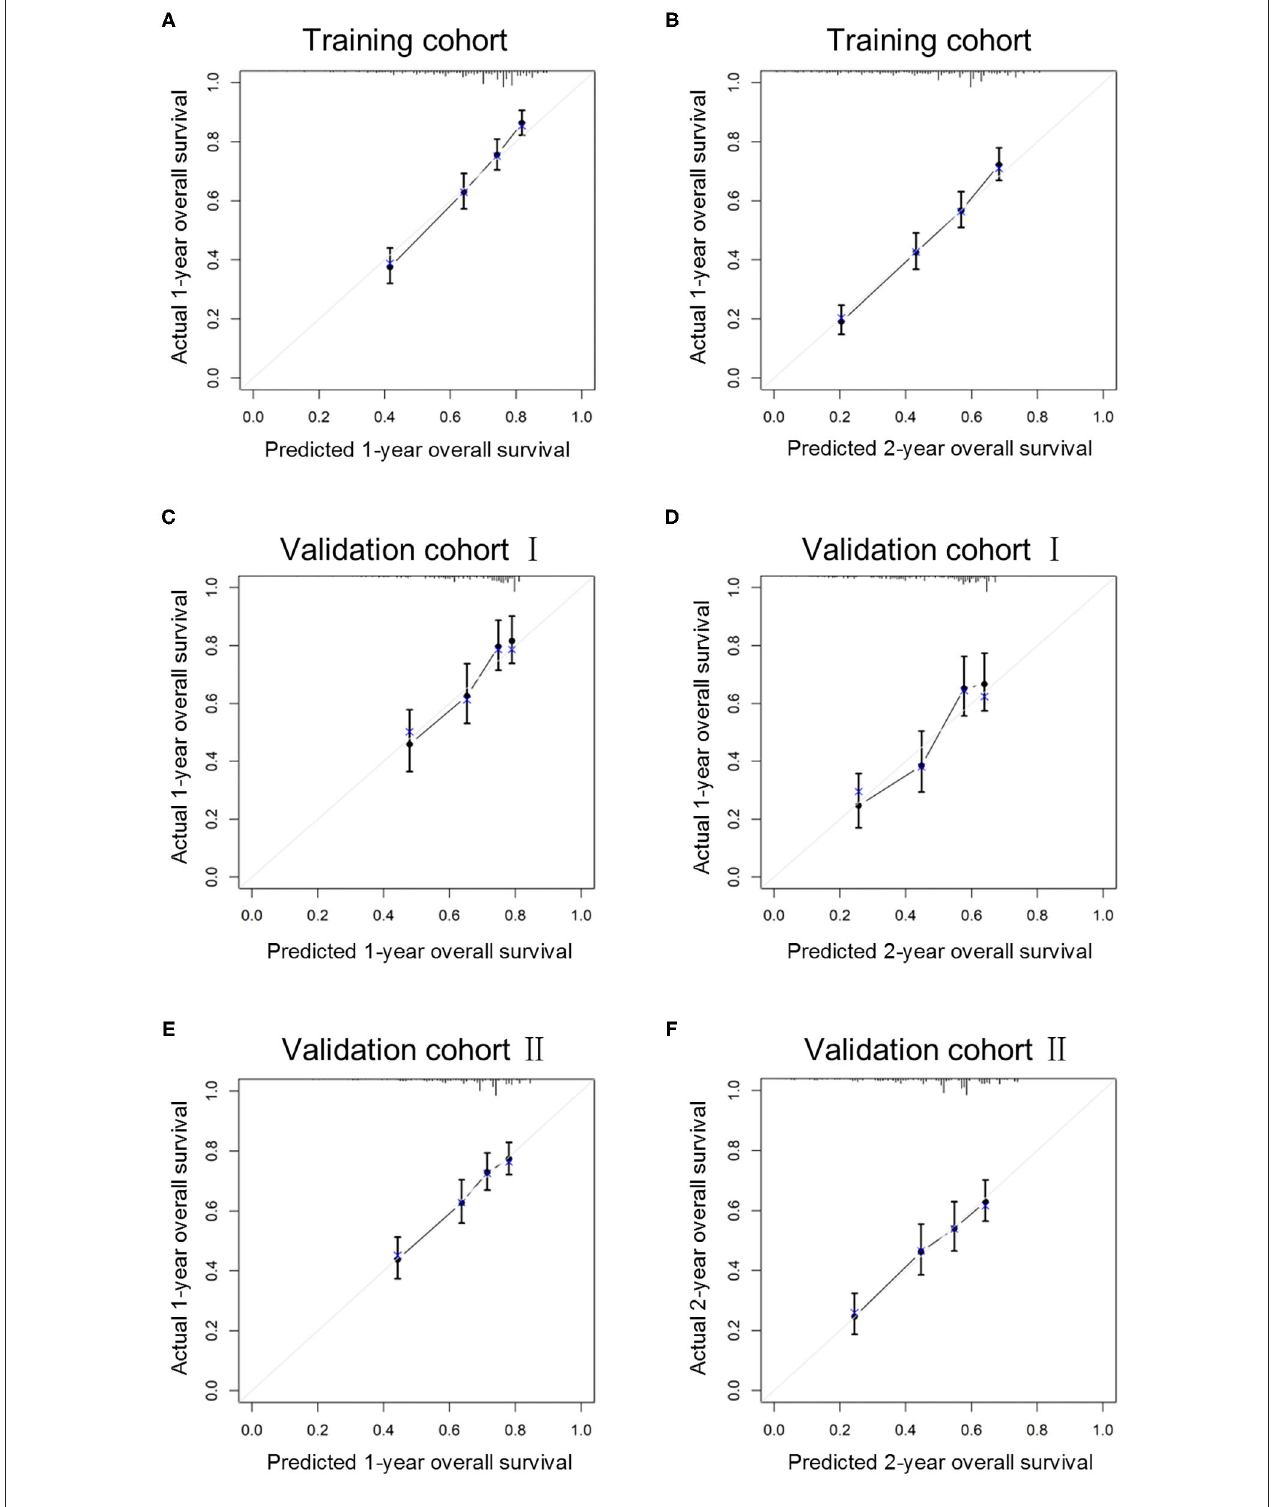
FIGURE 3 | Calibration curves of the ability of the nomogram to predict 1-year (A) and 2-year (B) overall survival in the training cohort, 1-year (C) and 2-year (D) overall survival in validation I cohort and 1-year (E) and 2-year (F) overall survival in validation II cohort.